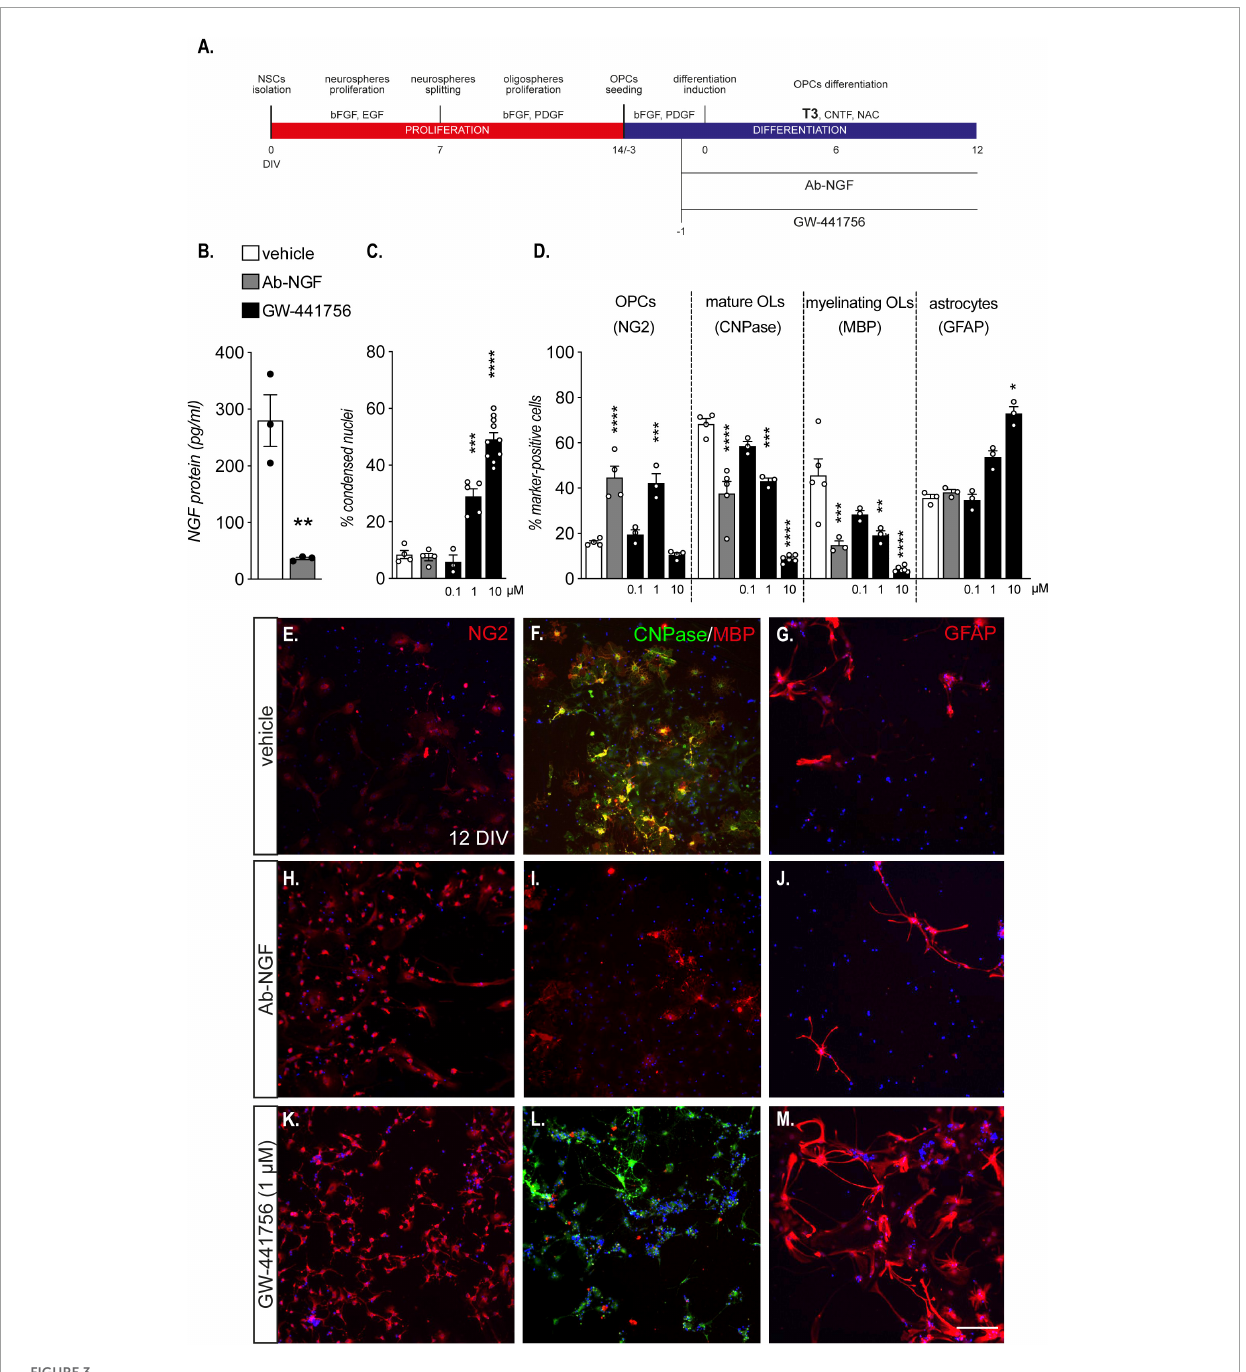
FIGURE3 Endogenous NGF is essential for OPCs differentiation. (A) NSC-derived mixed OPC/astrocyte cultures were exposed to an antibody anti-NGF (Ab-NGF) or GW-441756 from 24 h prior to T3 exposure (–1 DIV) to the end of the differentiation (12 DIV). (B) Graph shows the absolute NGF protein quantification (pg/ml) at the end of the differentiation phase (12 DIV) in cultures treated with vehicle or Ab-NGF ( n = 3). (C) : Graph shows the percentage of cell death expressed as percentage of condensed nuclei at the end of differentiation phase (12 DIV) in cells treated with vehicle ( n = 4), Ab-NGF ( n = 4) or different concentrations of GW-441756 (0.1 µ M, n = 3; 1 µ M, n = 5; 10 µ M, n = 10). (D) Graph shows the percentage of marker-specific cells for OPCs (NG2), mature OLs (CNPase) and myelinating OLs (MBP), at the end of the differentiation phase (12 DIV) in cells treated with vehicle (NG2, n = 4; CNPase, n = 4; MBP, n = 5; GFAP, n = 3), Ab-NGF (NG2, n = 4; CNPase, n = 4; MBP, n = 3; GFAP, n = 3) or different concentrations of GW-441756 (0.1 µ M, n = 3; 1 µ M, n = 3; 10 µ M, NG2, n = 4; CNPase, n = 6; MBP, n = 3). E – M: Representative images of cells stained for NG2 (E,H,K) , CNPase/MBP (F,I,L) and GFAP (G,J,M) of cultures treated with vehicle (E–G) , Ab-NGF (H–J) or GW-441756 1 µ M (K–M) . Scale bar (M) : 50 µ m. Bars represent mean ± SEM and single dots in the graphs represent single protein quantifications from independent samples (B) or independent experiments analyzed by high content screening (C,D) . Statistical analysis: Student’s t -test (B) , One-way ANOVA followed by Dunnet’s post-test (C,D) or Kruskal-Wallis test followed by Dunn’s post-test (panel D , GFAP). Asterisks represent the differences between cultures treated with vehicle or Ab-NGF (* p < 0.05; ** p < 0.01; *** p < 0.001; **** p < 0.0001). Ab-NGF, antibody anti-nerve growth factor; CNPase, 2 (cid:48) ,3 (cid:48) -cyclic nucleotide 3 (cid:48) -phosphodiesterase; bFGF, basic fibroblast growth factor; DIV, day in vitro ; EGF, epidermal growth factor; MBP, myelin basic protein; NG2, chondroitin sulphate proteoglycan, neural/glial antigen 2; NGF, nerve growth factor; OLs, oligodendrocytes; OPCs, oligodendrocyte precursor cells; PDGF, platelet derived growth factor; T3,